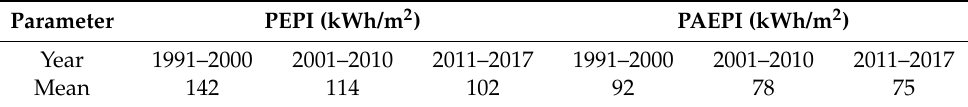
Table 3. Comparison of different categories of mosques based on year built, showing the existing and post-audit energy performance index mean